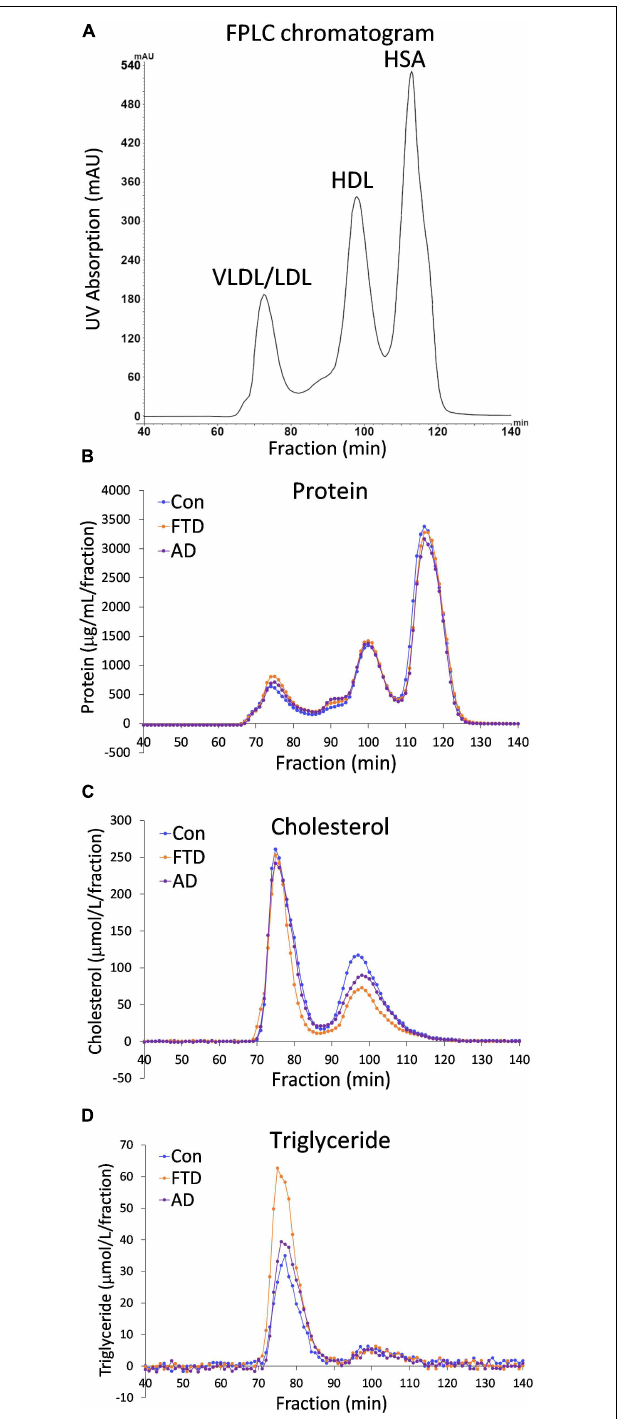
FIGURE 1 | Fast protein liquid chromatography (FPLC) profiles of behavioral variant frontotemporal dementia (bvFTD), Alzheimer’s disease (AD), and control plasmas. (A) A typical FPLC chromatogram shows peaks at ∼ 75, 100 and 115 min that correspond to very low density lipoproteins/low density lipoproteins (VLDLs/LDLs), high density lipoproteins (HDLs), and human serum albumin (HSA), respectively. (B) FPLC protein profiles. (C) FPLC cholesterol profiles. (D) FPLC triglyceride